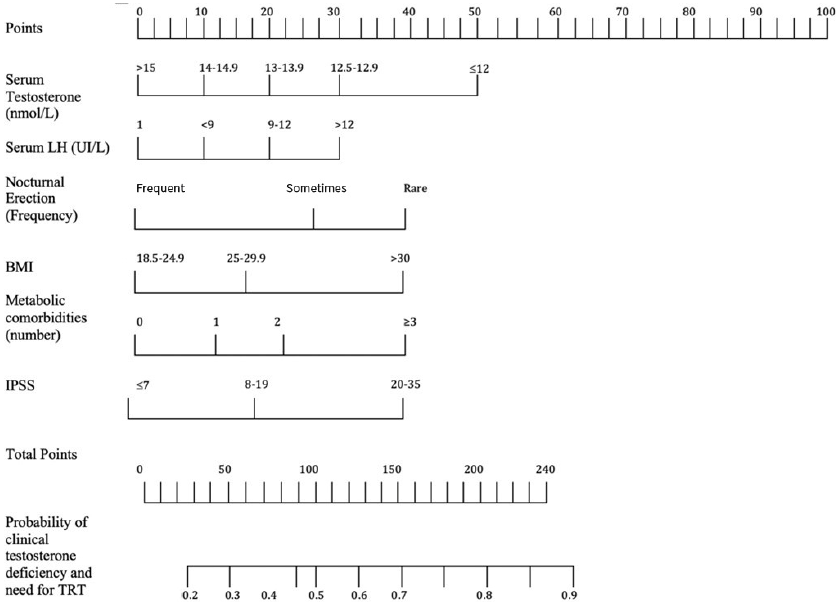
Figure 1. The figure shows the TRACE nomogram. In order to use the nomogram, draw a line perpendicular from the corresponding axis of each risk factor until it reaches the top line labeled “Points.” Sum up the number of points for all risk factors then draw a line descending from the axis labeled “Total Points” until it intercepts each of the survival axes to determine the probability of clinical testosterone deficiency and the need for testosterone therapy.